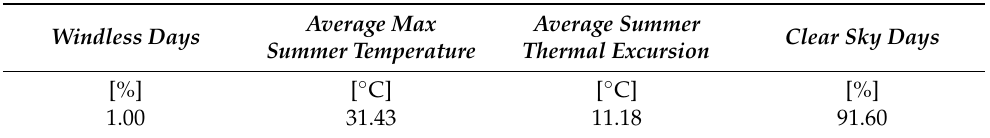
Table 2. Meteorological variables calculated for the city of Bari, data acquired by ARPA’s weather stations and Tutiempo database (period summer 2021).